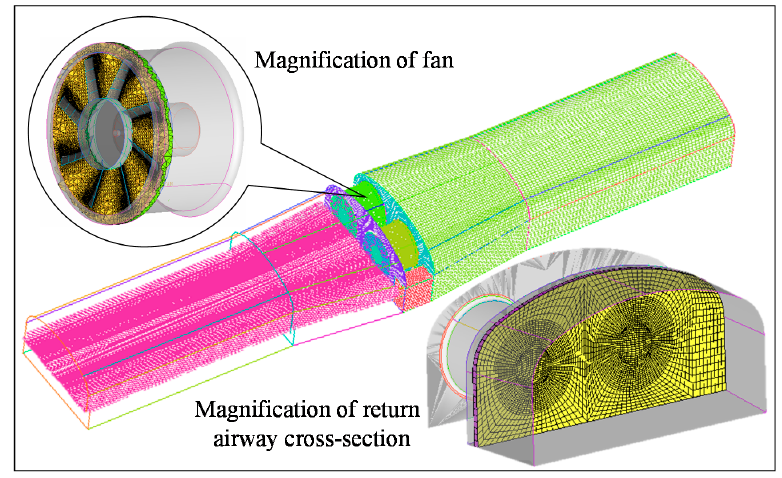
Figure 4. Mesh generated in model and local mesh refinement.